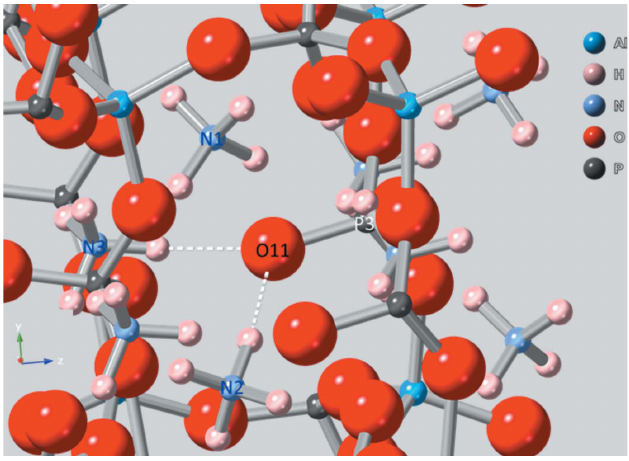
Figure 3 Atomic position overlay plot of SIZ-2 (blue) and (NH 4 ) 3 Al 2 (PO 4 ) 3 (red) showing that most atom positions are within 0.03 A˚ of each other. The most significant difference is in the O11 position.